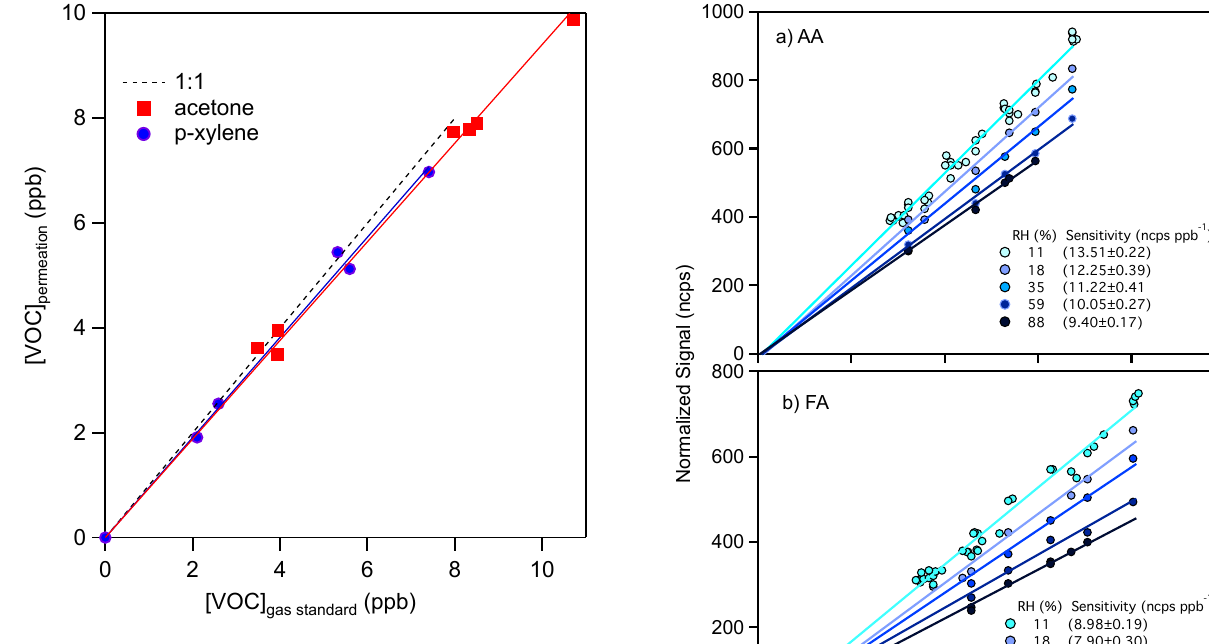
Figure 2. Validation of the permeation-based VOC calibration sys- tem based on known concentrations of p -xylene and acetone. In both cases, mixing ratios derived from a permeation-based calibra- tion are compared to the actual values from a certified gas-phase standard. Good agreement (within 5%) is found for both species.